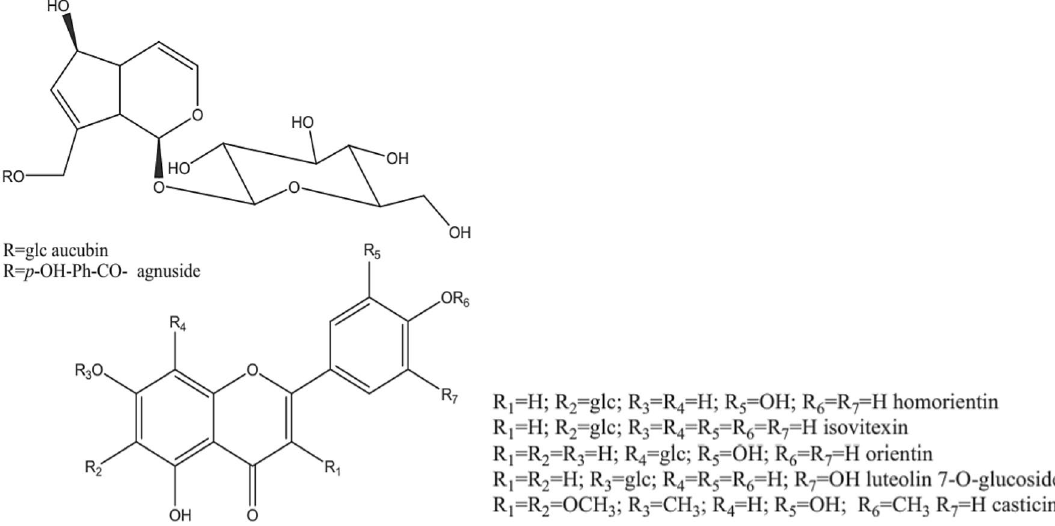
Fig. 3 Chemical structure of Vitagnus (Mari et al.